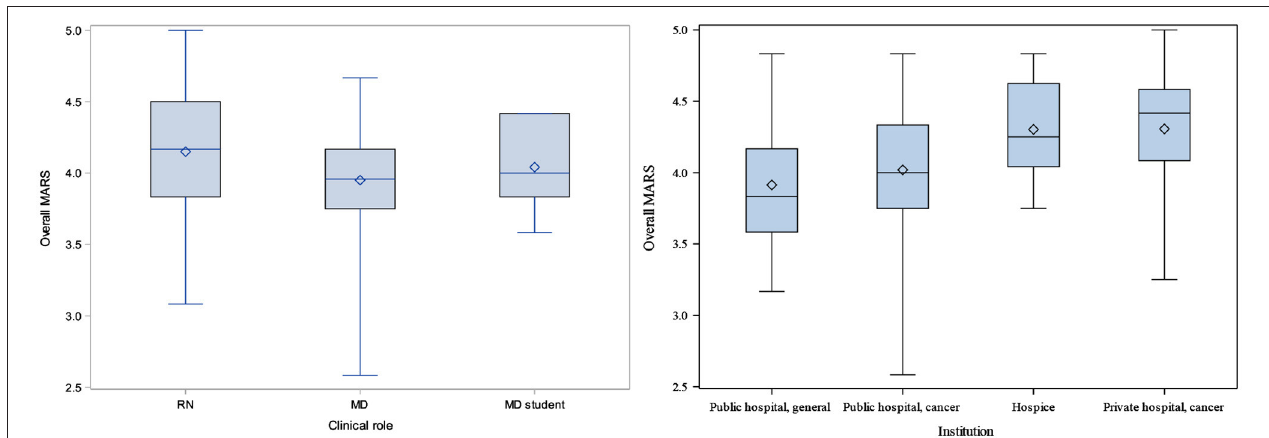
FIGURE 5 | Overall MARS scores by clinical role (L) and institution